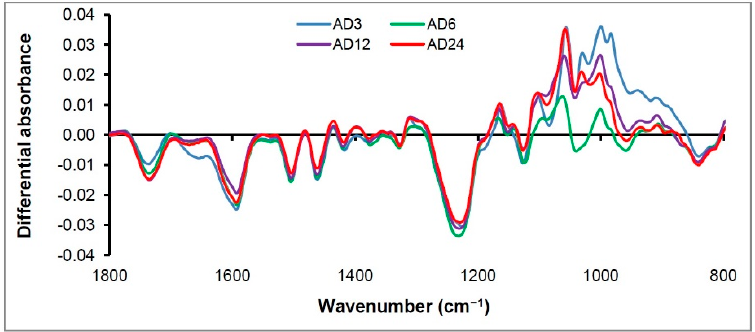
Figure 14. Differential FTIR spectra of black locust samples.